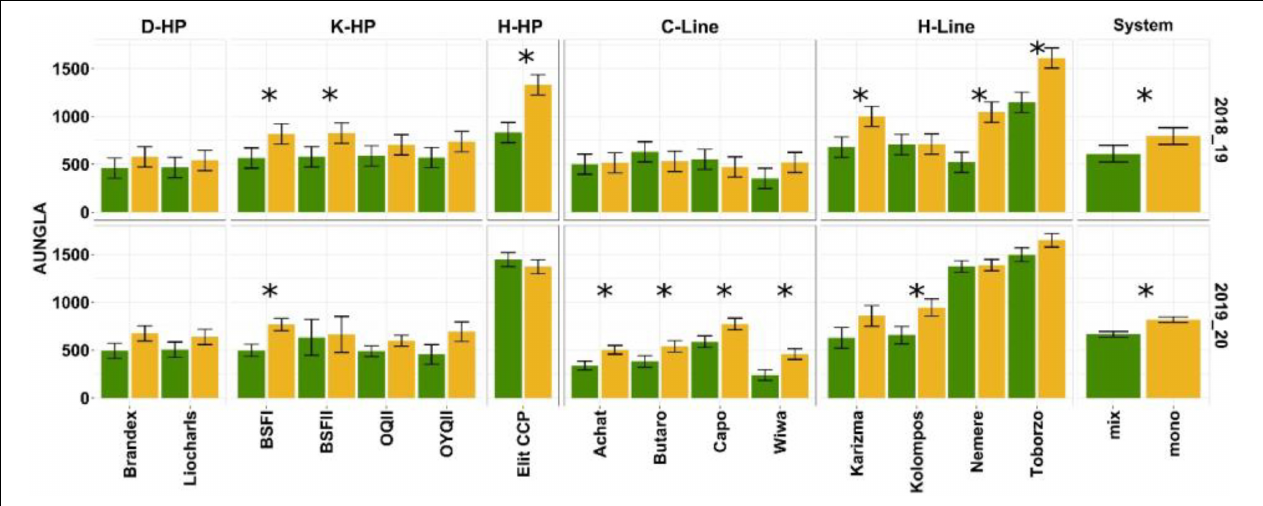
FIGURE 3 | Area under the curve for non-green leaf area (AUNGLA). Wheat-pea mixtures are indicated in green and monoculture treatments in yellow. Estimated marginal means and standard error for the 2018/19 and 2019/20 seasons. Asterisks indicate significant differences at P < 0.05 between mixtures and monocultures in wheat entries estimated from lmes followed by pairwise comparison with Holm correction. Error bars indicate standard error.